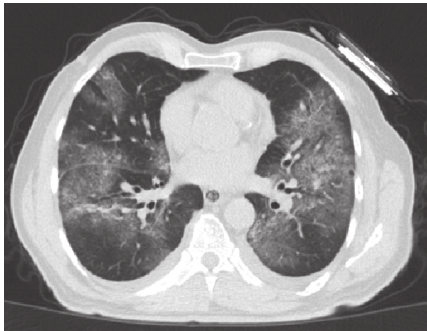
Figure 2: GGO with interlobular septal thickening in a case of COVID-19 at the subacute phase (note to pleural